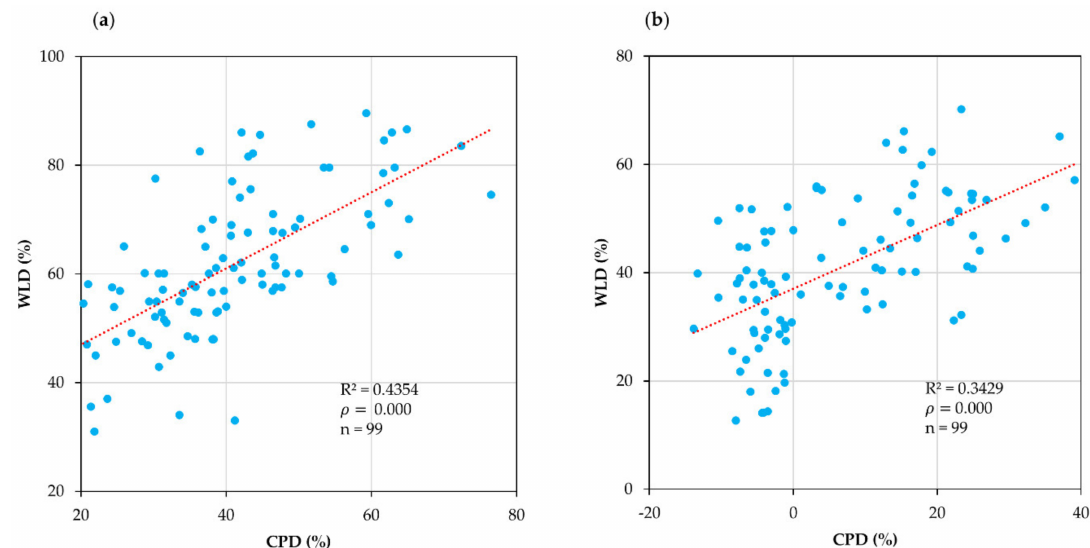
Figure 6. Relationship between change in population density (CPD) and density of wetland loss due to settlement expansion (WLD) in the MMNL during ( a ) 1997–2007 (TP1) and ( b ) 2007–2017 (TP1). Each point is a GN